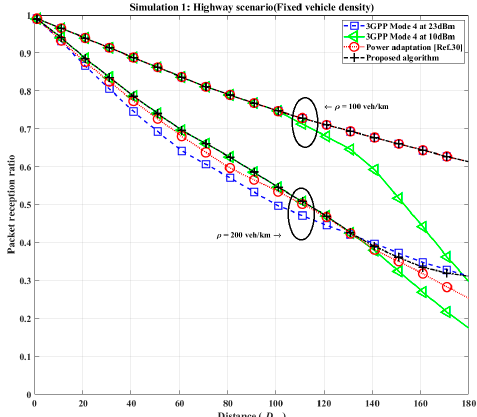
Figure 7. Packet reception ratio as a function of the distance between the transmitter and receiver ( D xy ) in highway scenario with fixed traffic density.